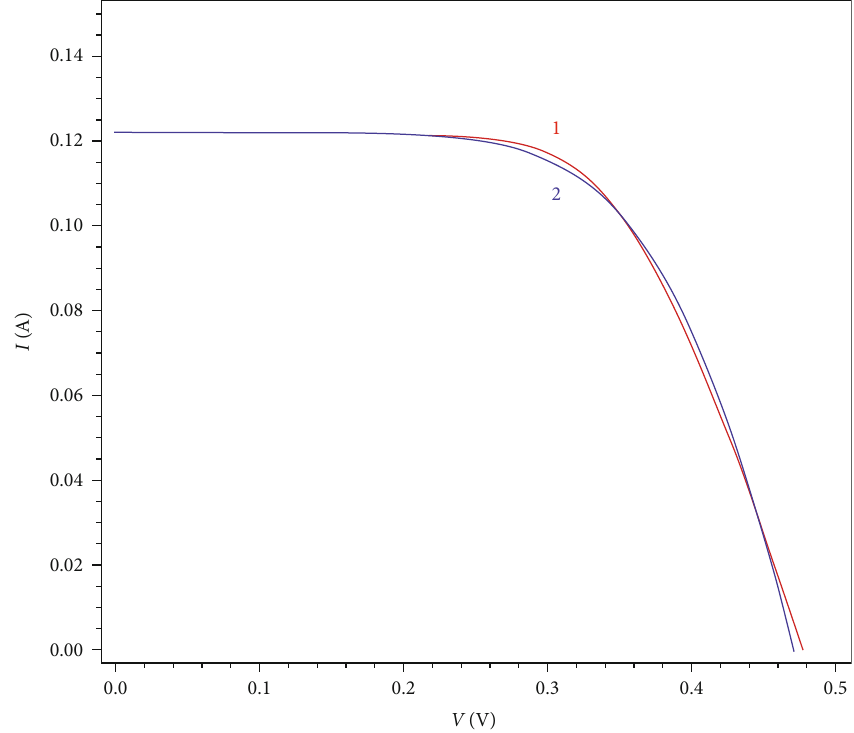
: 1225A (2) and overlapping of curves ph = 0